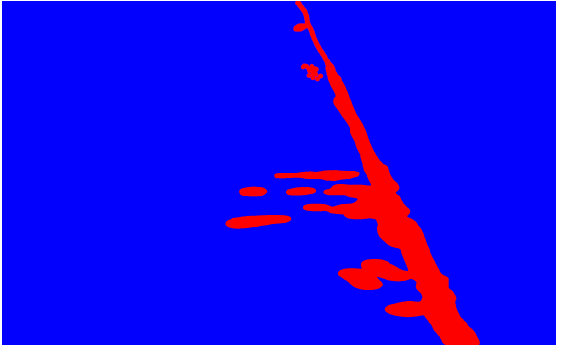
Figure 4. The semantic segmentation performed directly on the input (perspective) image (Figure 3). This approach is similar to the one of popular datasets like Cityscapes. Initial experiments with this setting showed its effectiveness, but the system has been further improved via orthogonal perspective